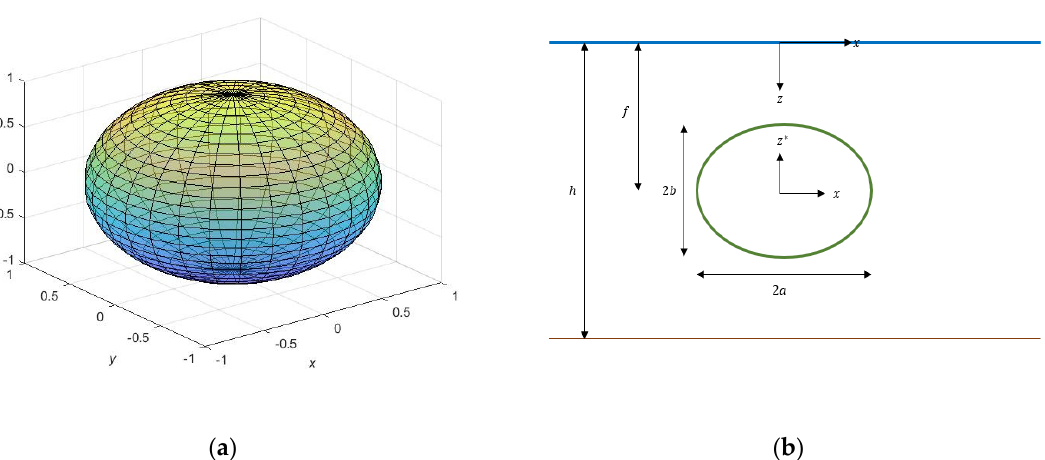
Figure 1. ( a ) A 3D image of an axisymmetric oblate spheroid; ( b ) A 2D schematic of the problem in the 𝑥 − 𝑧 plane.